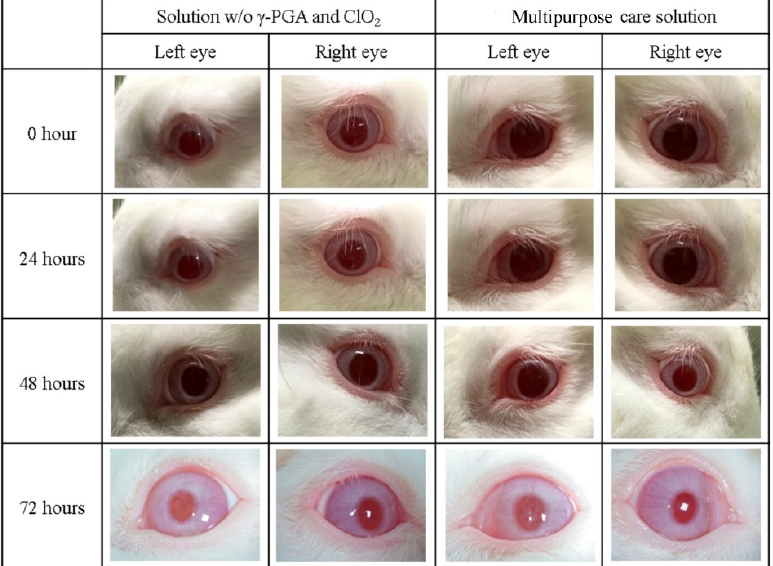
Figure 2. Irritation testing demonstrates the multipurpose contact lens care solution does not cause irritation of rabbit eyes. Contact lens care solution without γ -PGA and ClO 2 , or the multipurpose care solution was administrated on rabbit eyes. Rabbit eyes were observed three times every 24 h. None of the solutions caused any irritation at the time of observation.